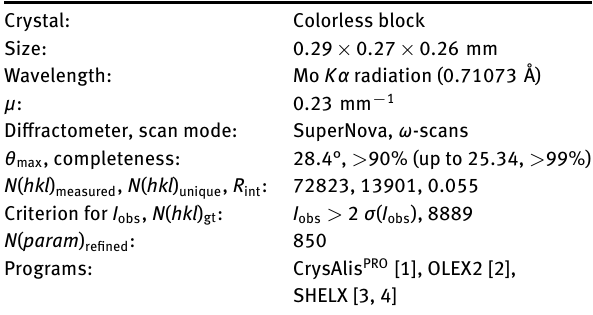
Table 1: Data collection and